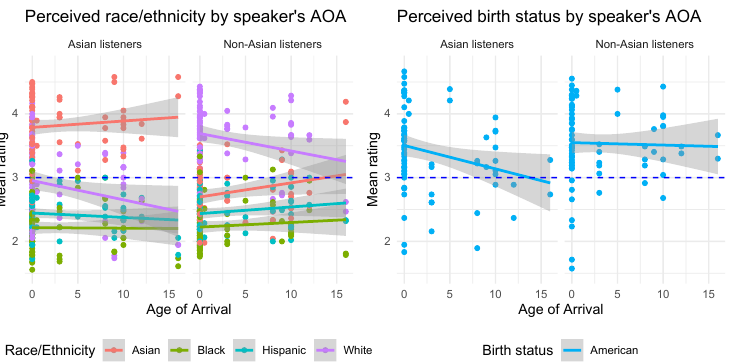
Figure 3. Age of Arrival was shown to have a modest effect on mean White ratings and mean American ratings, but not on perceived Asian, Black, or Hispanic/Latino identity. In addition, Asian listeners (n = 37) and non-Asian listeners (n = 68) rated the speakers very differently in terms of perceived Whiteness and